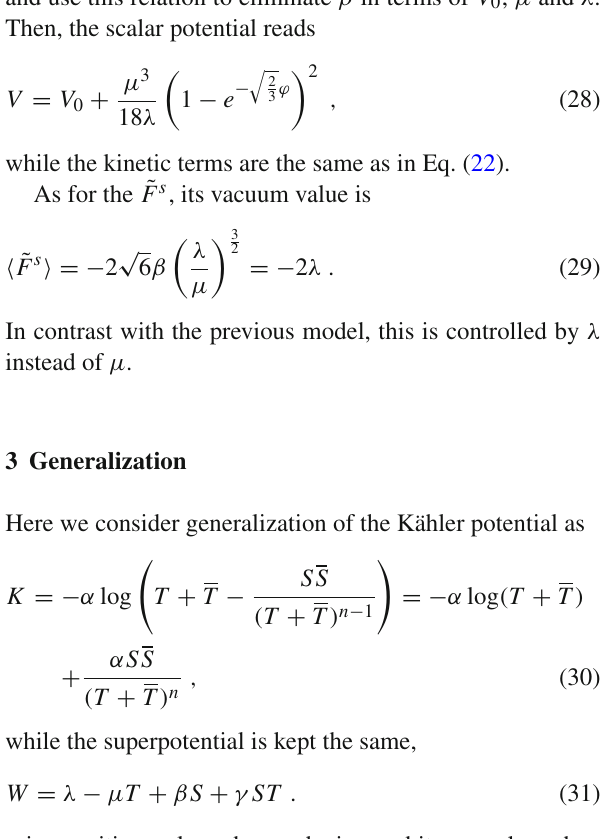
ϕ = ϕ f , dotted line for